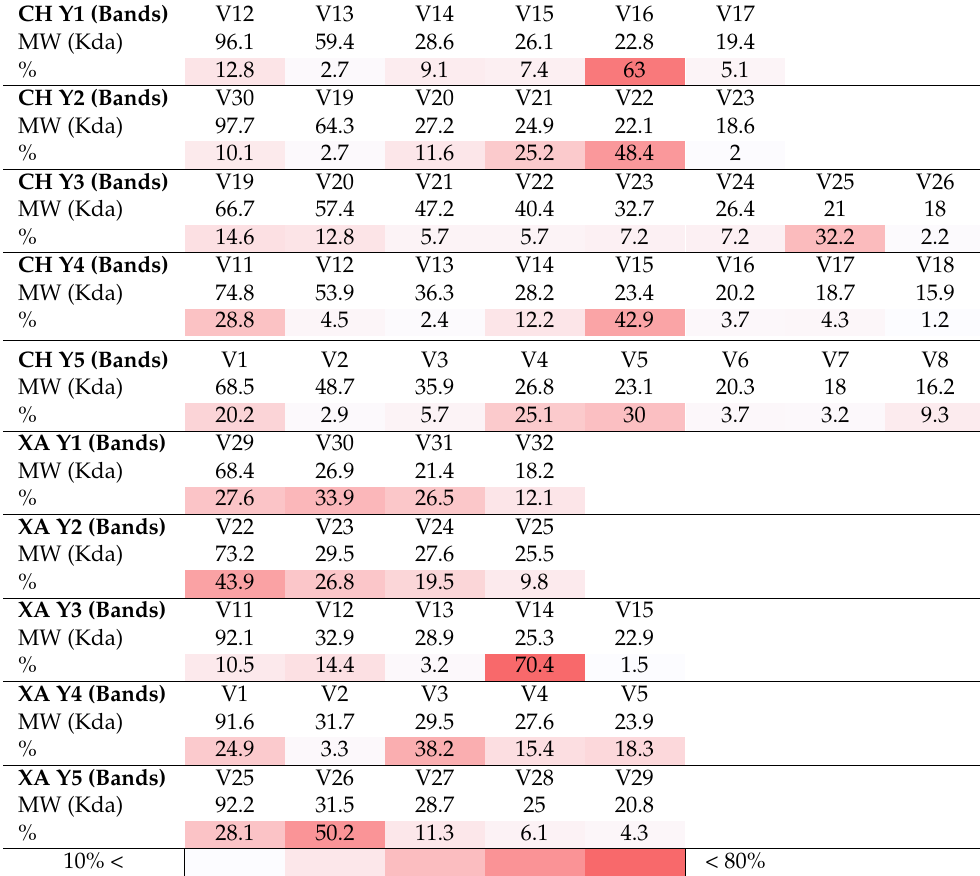
Table 2. Analysis of the protein profile by SDS-PAGE and quantification in terms of the percent- age of protein bands fractions (%) by detecting their molecular weights (MW), of the base wine of Chardonnay (CH) and Xarel.lo (XA) elaborated with different yeast strains: Saccharomyces cere- visiae (Y1, Y2, Y3) and non-Saccharomyces, M. pulcherrima (Y4) and T. delbrueckii (Y5).